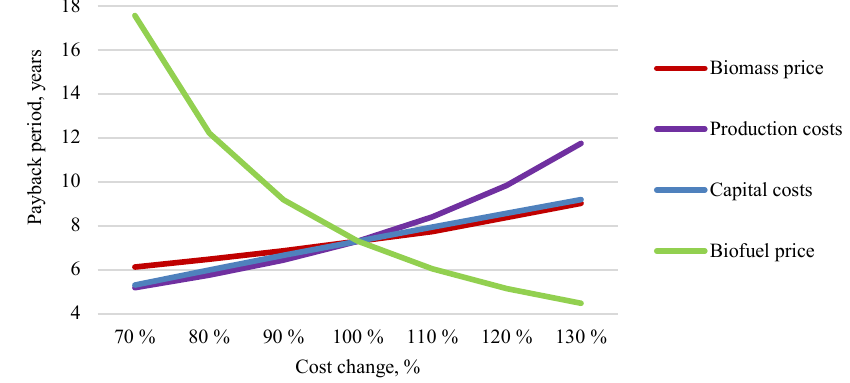
Fig. 6. Sensitivity analysis for payback